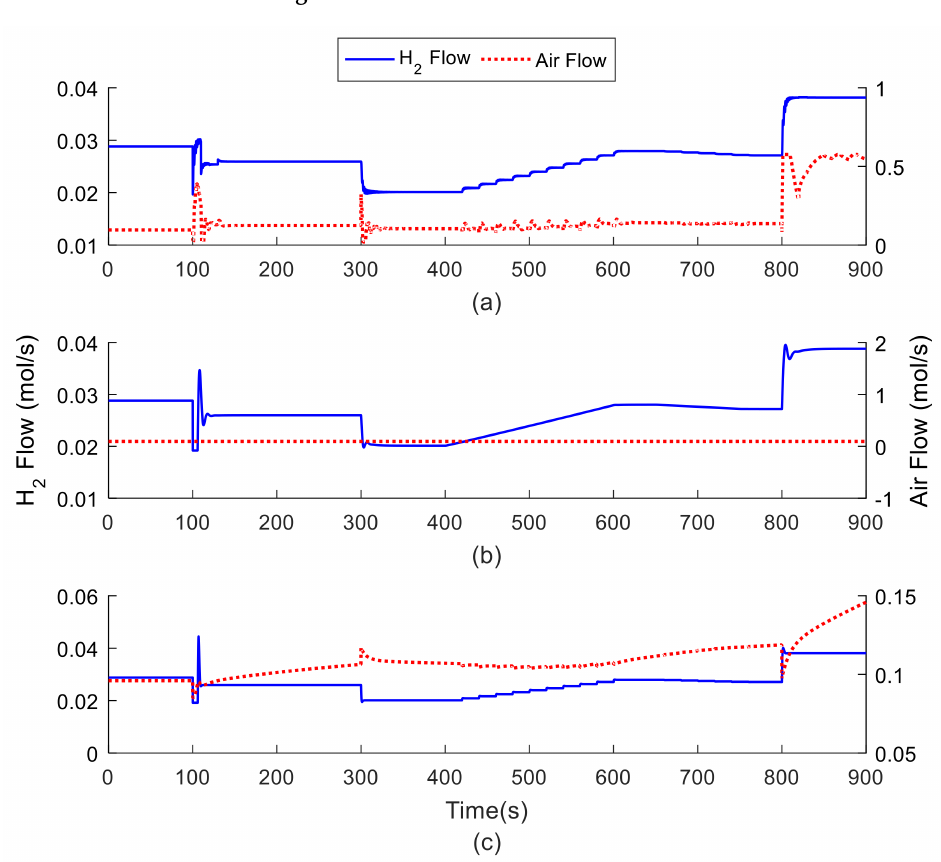
Figure 12. The manipulated inputs. ( a ) SP Scheduler + L1-MPC, ( b ) Only PID, and ( c ) SP Scheduler +